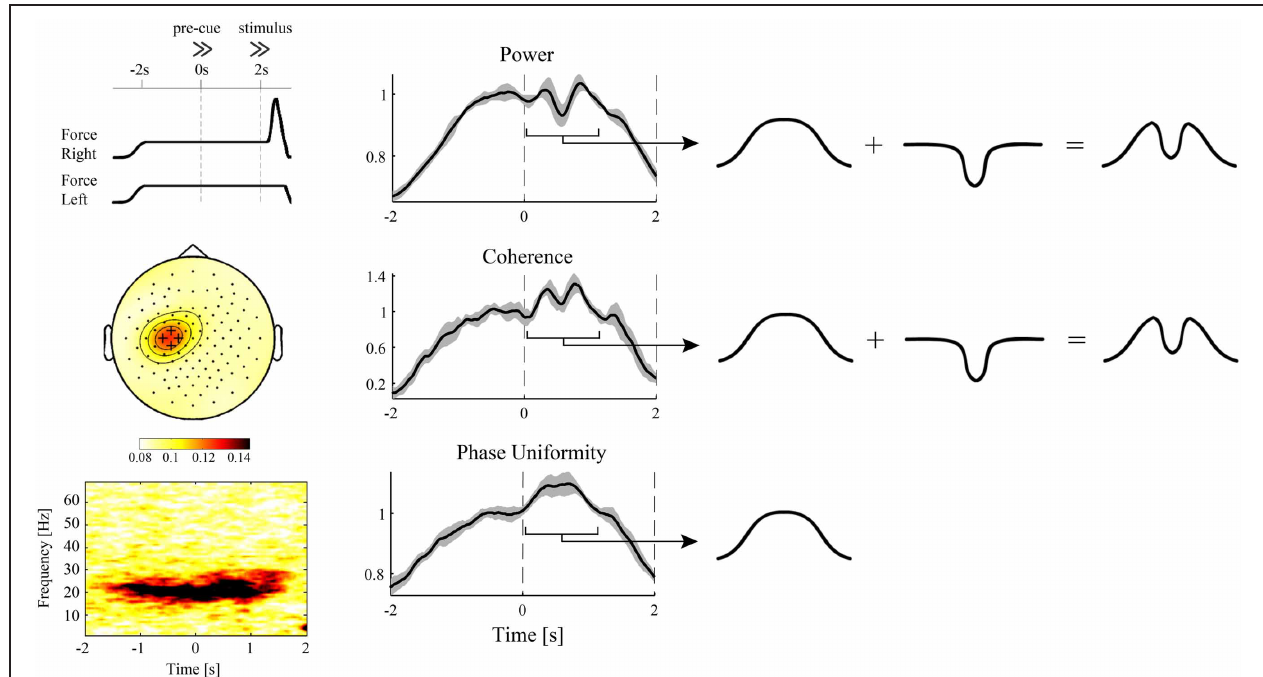
FIGURE 1 | Evidence for independent modulations in cortical power and corticospinal synchronization? EEG and hand muscle EMG were recorded during a pre-cued reaction time task with either the left or right hand as response hand (van Wijk et al., 2009). During the interval between pre-cue and stimulus, which required static force production, significant beta band coherence between the EMG and sensors overlying the contralateral motor cortex was observed ( left panels ). The same electrodes showed a brief cue-related drop in spectral power ( middle panels ). Looking at the different time courses for power, corticospinal coherence, and corticospinal relative phase uniformity [also referred to as “phase-locking index” (Mardia, 1972;